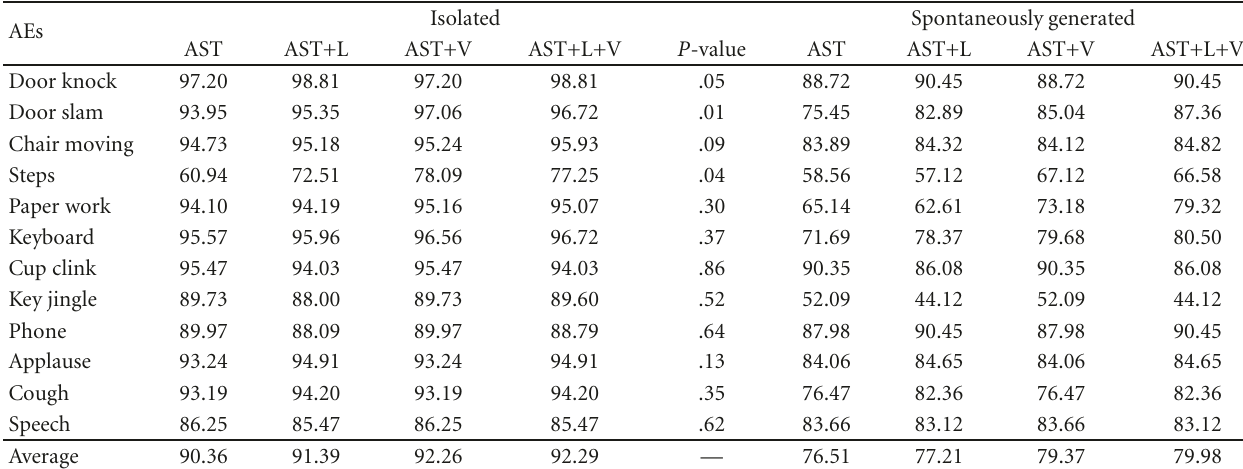
Table 4: Fusion of di ff erent modalities using isolated and spontaneously generated